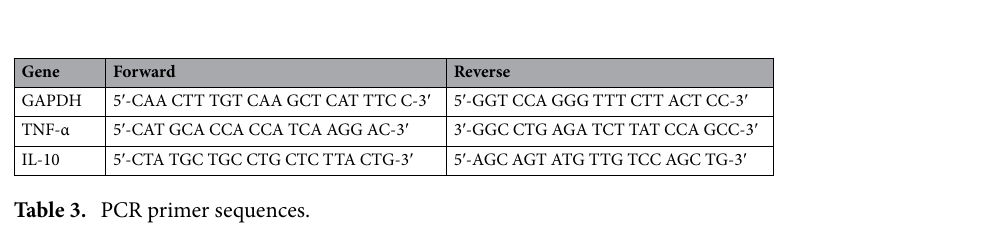
Table 2. Pathological inflammation score in the small intestine.